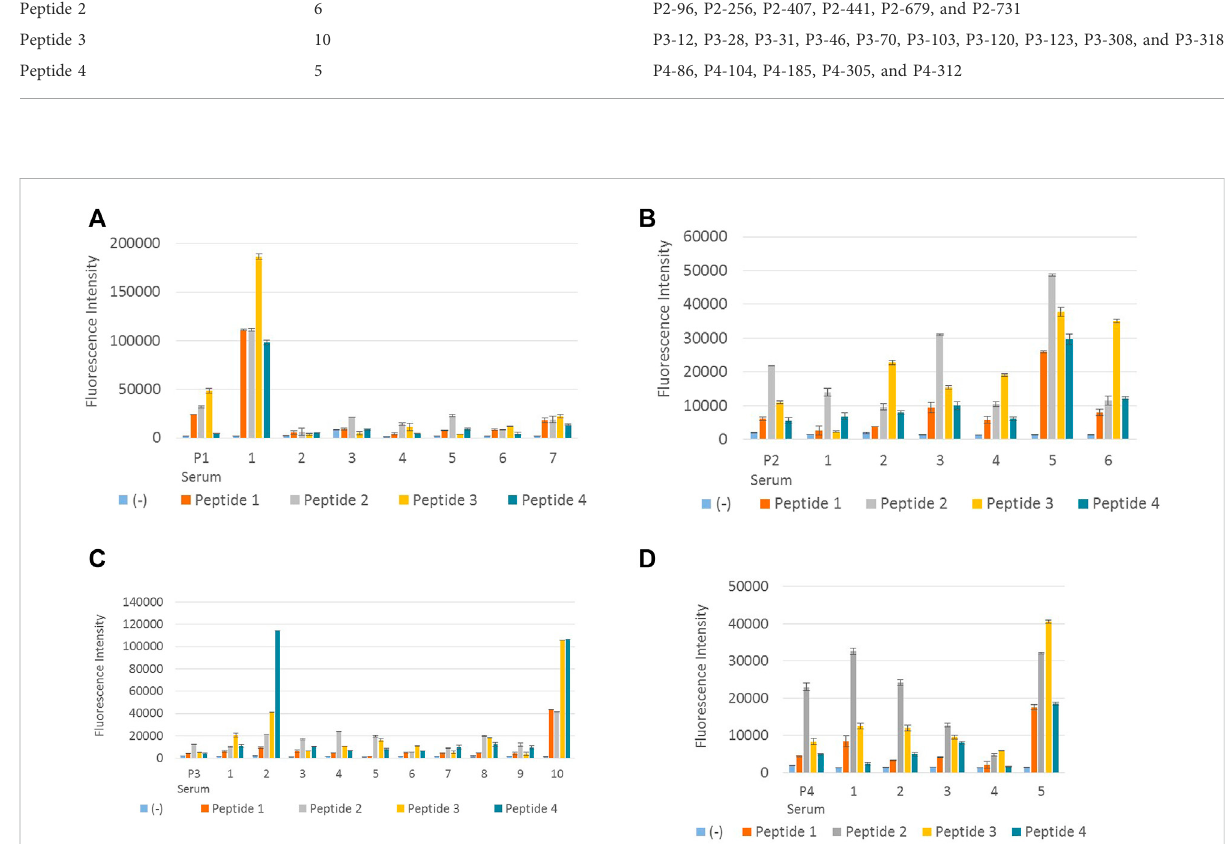
FIGURE 2 ScreeningofhybridomaclonesreactingwithDENVNS1peptides. (A) FluorescenceintensitymeasurementsofIgG-secretinghybridomaclones generated from peptide 1 – immunized mouse reacting with all four DENV NS1 peptides. P1 serum denotes polyclonal antiserum from peptide 1 – immunized mouse. Columns 1 – 7 denote supernatant from seven hybridoma clones: P1-18, P1-44, P1-122, P1-195, P1-252, P1-267, and P1-285, respectively. (B) Fluorescence intensity measurements of IgG-secreting hybridoma clones generated from peptide 2 – immunized mouse, reacting with all four DENV NS1 peptides. P2 serum denotes polyclonal antiserum from peptide 2 – immunized mouse. Columns 1 – 6 denote supernatant from six hybridoma clones: P2-96, P2-256, P2-407, P2-441, P2-679, and P2-731, respectively. (C) Fluorescence intensity measurementsofIgG-secretinghybridomaclonesgeneratedfrompeptide3 – immunizedmousereactingwithallfourDENVNS1peptides.P3serum denotes polyclonal antiserum from peptide 3 – immunized mouse. Columns 1 – 10 denote supernatant from 10 hybridoma clones: P3-12, P3-28, P3- 31, P3-46, P3-70, P3-103, P3-120, P3-123, P3-308, and P3-318, respectively. (D) Fluorescence intensity measurements of IgG-secreting hybridoma clonesgeneratedfrompeptide4 – immunizedmousereactingwithallfourDENVNS1peptides.P4serumdenotespolyclonalantiserumfrompeptide 4 – immunized mouse. Columns 1 – 5 denote supernatant from fi ve hybridoma clones: P4-86, P4-104, P4-185, P4-305, and P4-312, respectively. Column ( − ) in all (A – D) denotes the negative control (BSA). The hybridoma supernatant which contains anti-DENV NS1 monoclonal antibodies was diluted 1:1 in 6% BSA. Error bars represent the standard deviation ( n =